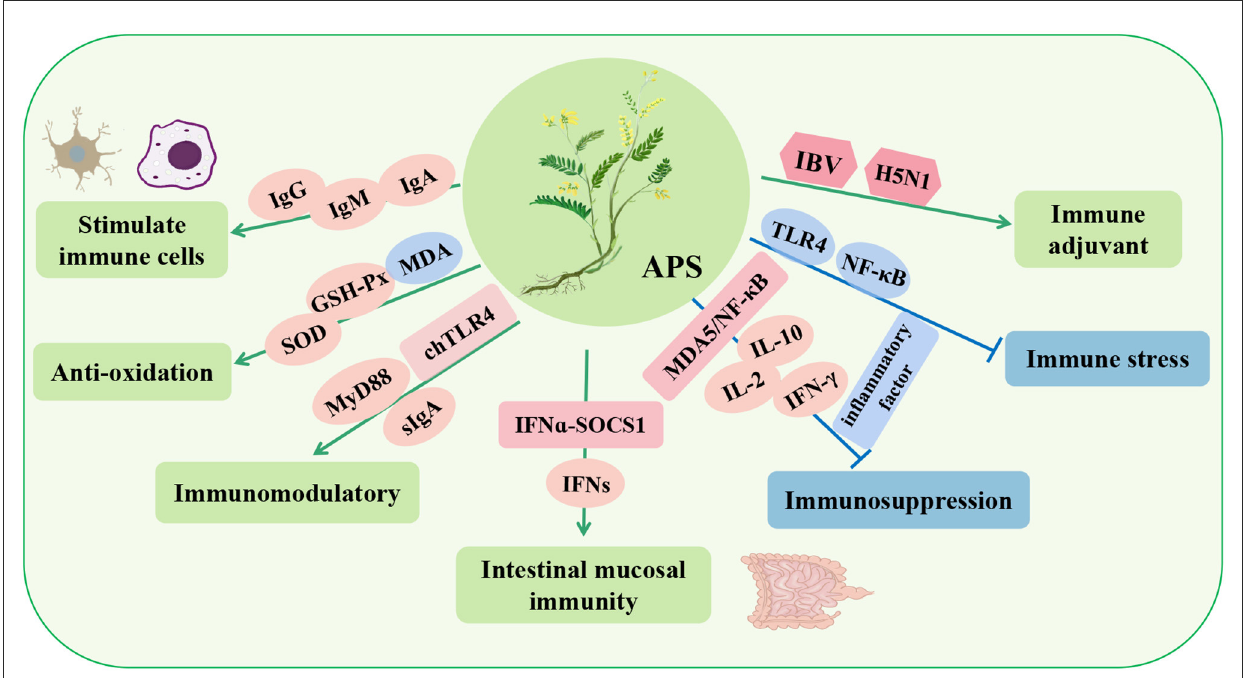
FIGURE2 Immunomodulatory effects and mechanisms of Astragalus polysaccharide (APS) in poultry. IgA, immunoglobulin A; IgM, immunoglobulin M; IgG, immunoglobulin G; SOD, superoxide dismutase; MyD88, myeloiddifferentiationfactor88; chTLR4, toll-like receptor 4; sIgA, secretory immunoglobulin A; IFNs, type-I-interferon; NF- κ B, nuclear factor- κ B; MDA5, interferon induced with helicase C domain 1; IL-2, interleukin-2; IBV, infectious bronchitis virus; H5N1, avian